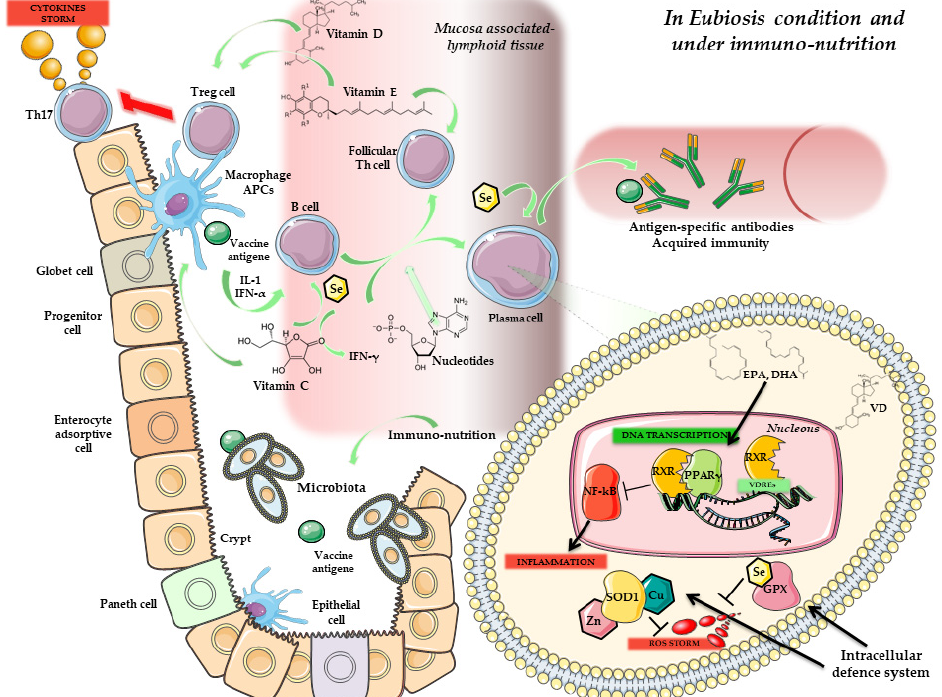
Figure 1. immune response in eubiosis condition and in immuno-nutrition. Figure 1. Immune response in eubiosis condition and in immuno-nutrition. Gut homeostasis is maintained through the cooperation between microbiota and several micronutrients, acting in a synergic and powerful way. Eubiosis is maintained by the specific immuno-nutrition (e.g., Vitamin E, Vitamin D, Vitamin C, Omega-3 Fatty acid as EPA and DHA, Se, Zn, Cu and Nucleotides). On the other hand, gut microbiota in eubiosis condition can cooperate with the immune system to preserve the intestinal barrier integrity. Mucosal APCs and associated lymphoid tissue can promote vaccine response, through antigen response and binding Tregs and B lymphocytes via IL-1 and IFN- α . Tregs, activated also through Vitamin E and D, can block Th17 lymphocytes and the related cytokines storm (i.e., IL-17) and suppress inflammation. At the same time, nucleotides, Se and Vitamin C can stimulate B cells to become plasma cells, and produce antigen-specific antibodies. Inside the B cell, the main intracellular signalling pathway promoted by NF-kB pathway related to inflammation is blocked via RXR/PPAR- γ heterodimer. The intracellular defence system, sustained by ROS, is balanced through SOD1 and GPx activity (with binding of Cu, Zn and Se, respectively). EPA and promote with RXR the anti-oxidant and anti-inflammation gene expression through the binding on VDREs. Abbreviation: Eicosapentaenoic acid (EPA); Docosahexaenoic acid (DHA); Selenium